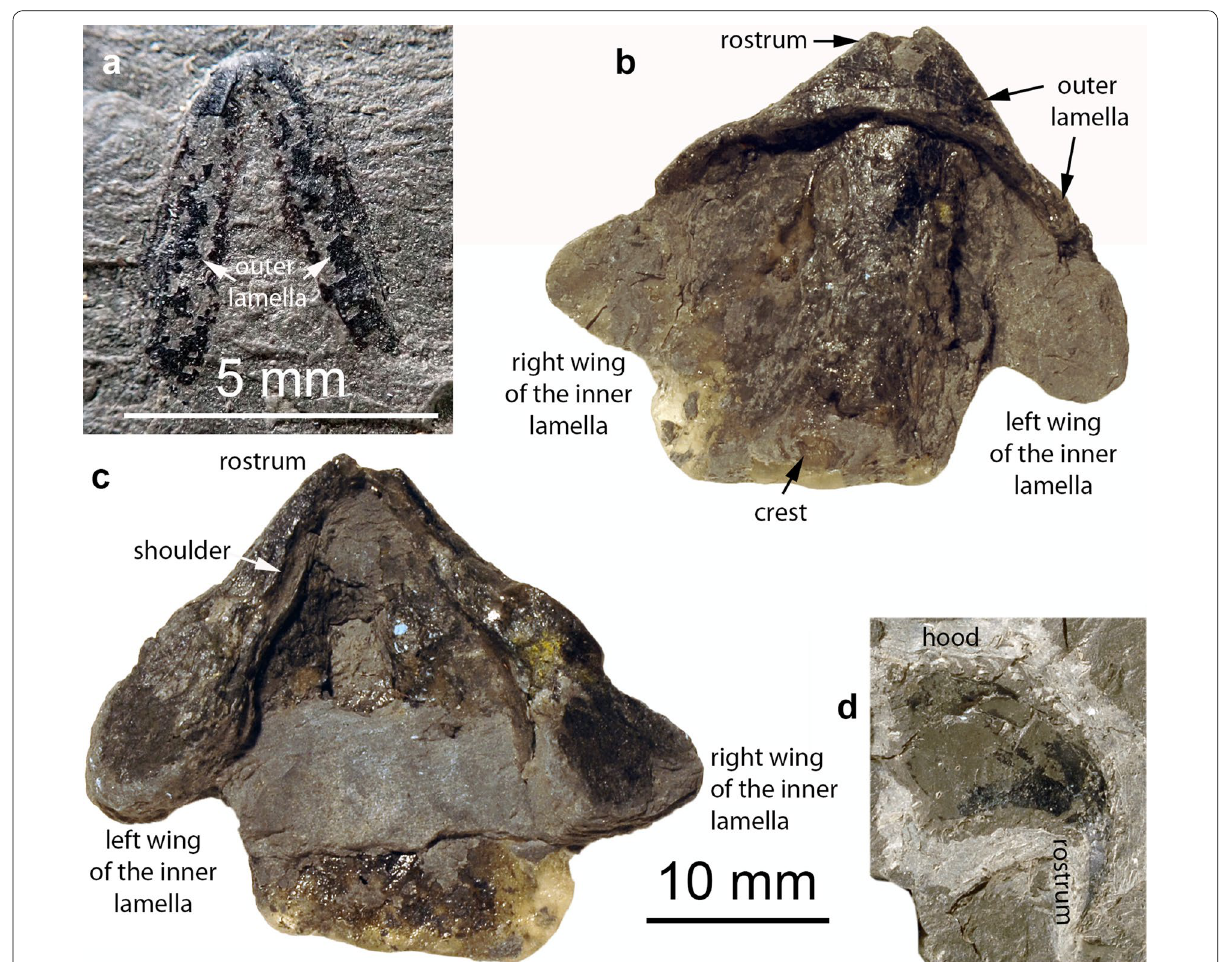
Fig. 2 Cephalopod jaws from the Opalinum Clay Formation of northern Switzerland. a PIMUZ 5942, upper jaw of an ammonoid ( Leioceras opalinum ?). b , c PIMUZ 6077, lower jaw of a megateuthid belemnite ( Acrocoelites conoideus ?); b ventral view, c dorsal view. d PIMUZ 6076, upper jaw of a megateuthid belemnite ( M. rhenana ?), seen